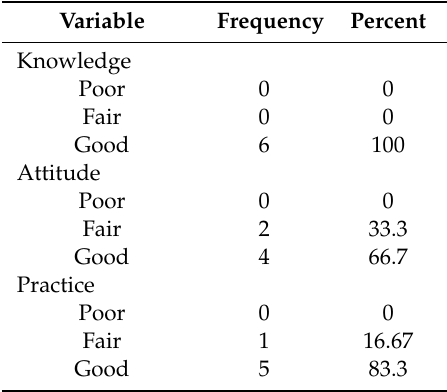
Table 7. Supervisor knowledge of chemical hazard warning signs, attitudes towards chemical laboratory safety, and chemical laboratory safety